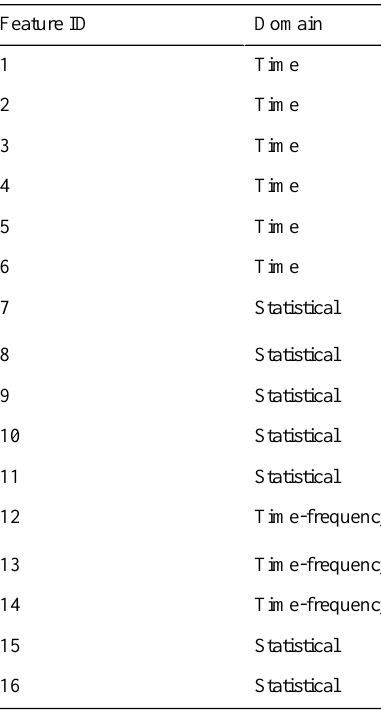
Table 1. Feature IDs and descriptions.